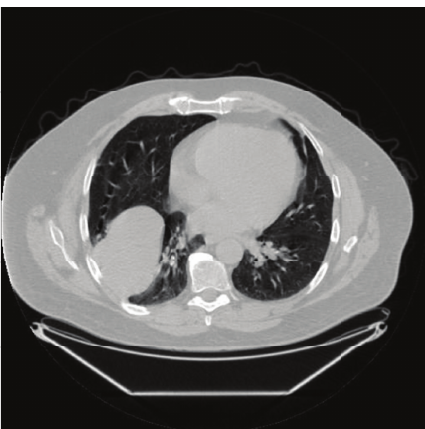
Figure 1: Chest computed tomography scan in lung window shows a well-circumscribed large solid mass.